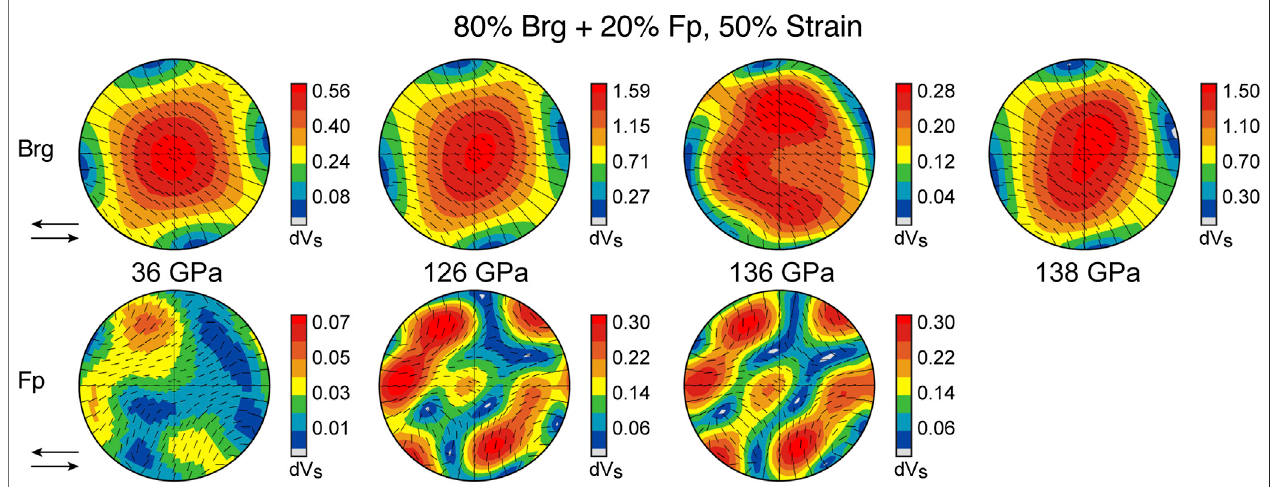
FIGURE11| Percentshear wavesplitting( δ V S ) forthe case of50%strain. The toprow (Brg) shows random ferropericlase orientationsand texture developmentin bridgmanite. The bottom row (Fp) shows random bridgmanite orientations and texture development in ferropericlase. Both rows assume a lower mantle composition of ∼ 80% bridgmanite and ∼ 20% ferropericlase. Sense of shear is top left, shown by the arrows. Eigenvectors of the fast S-wave polarization are shown as black dashes. Note that each hemispheric projection shows a different range of δ V S .